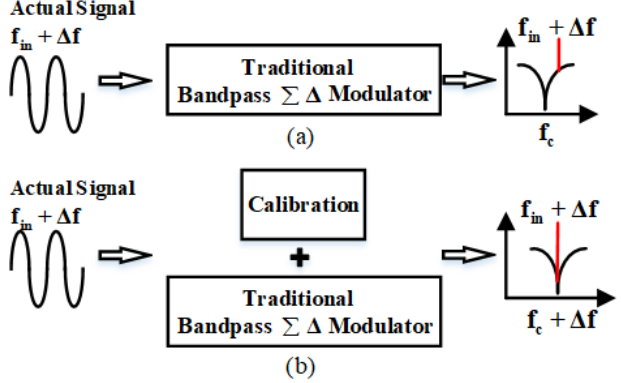
Figure 1. ( a ) The actual signal frequency mismatches the center frequency of the traditional bandpass sigma-delta ( Σ∆ ) modulator. ( b ) A calibration module added to the bandpass Σ∆ modulator can track the frequency change of the input signal.